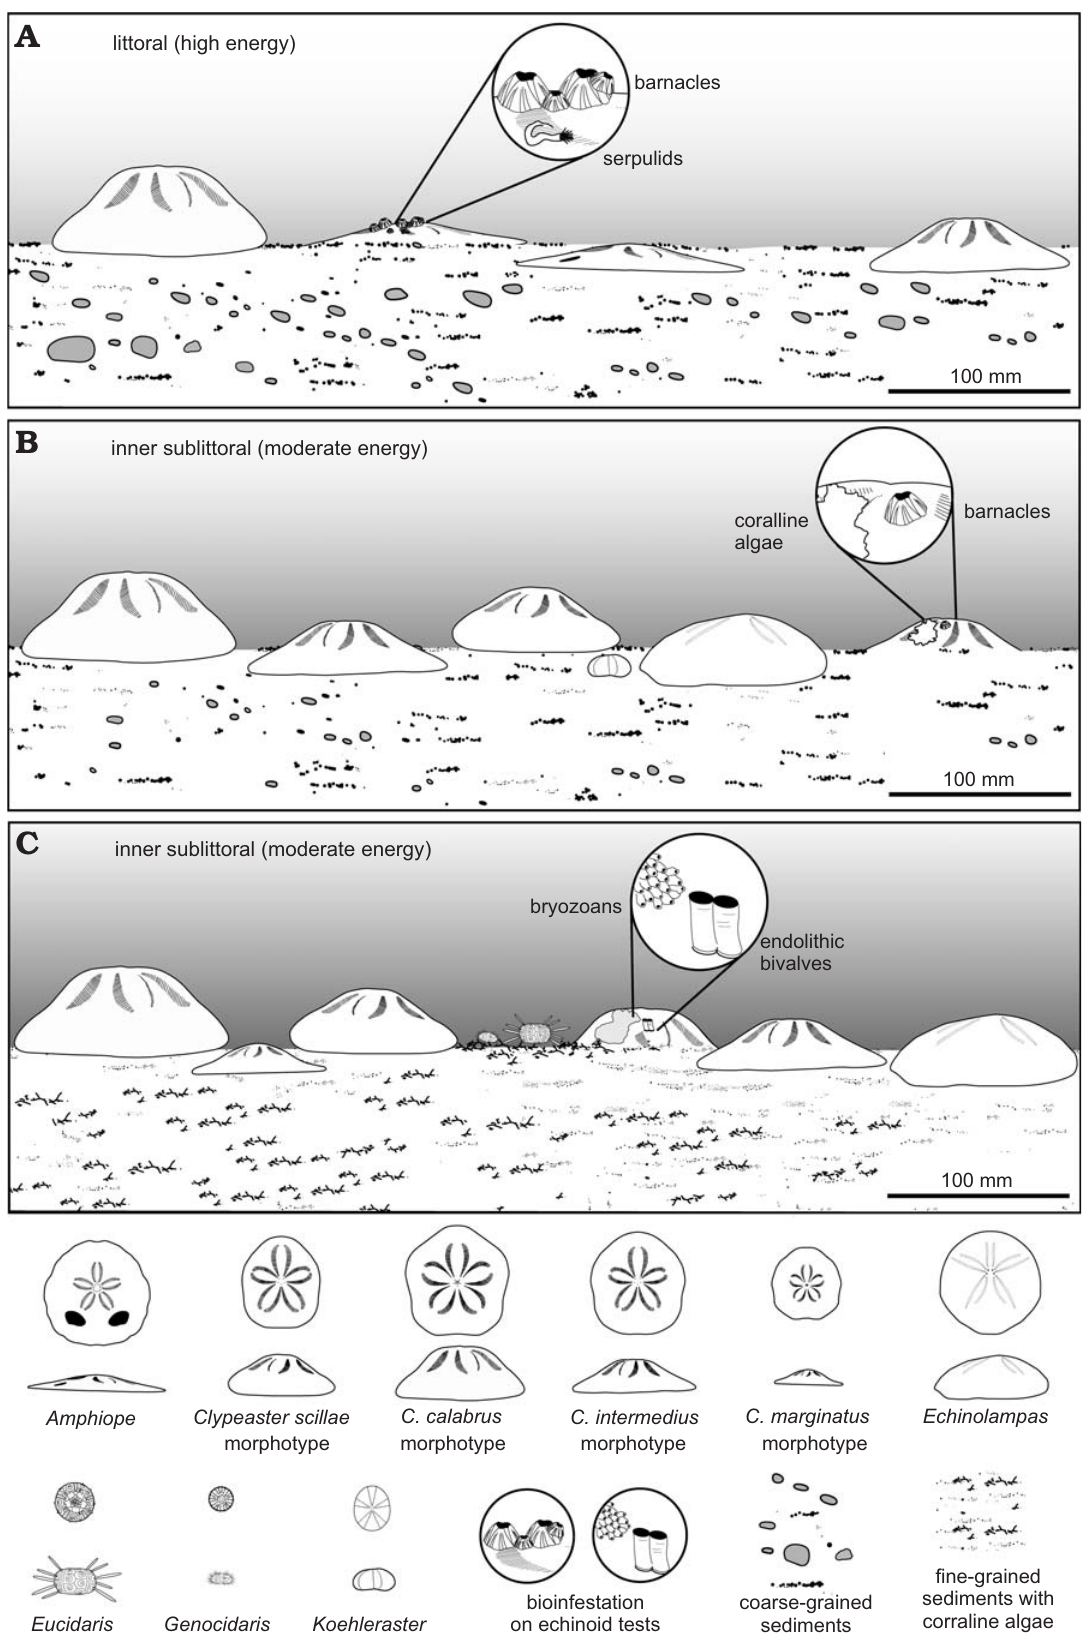
Fig. 8. Palaeoecological reconstruction of the echinoid assemblages recognized within early Miocene sections at Bancali and Usini, Sardinia, Italy. A . Bancali Assemblage 1. B . Bancali Assemblage 2. C . Usini